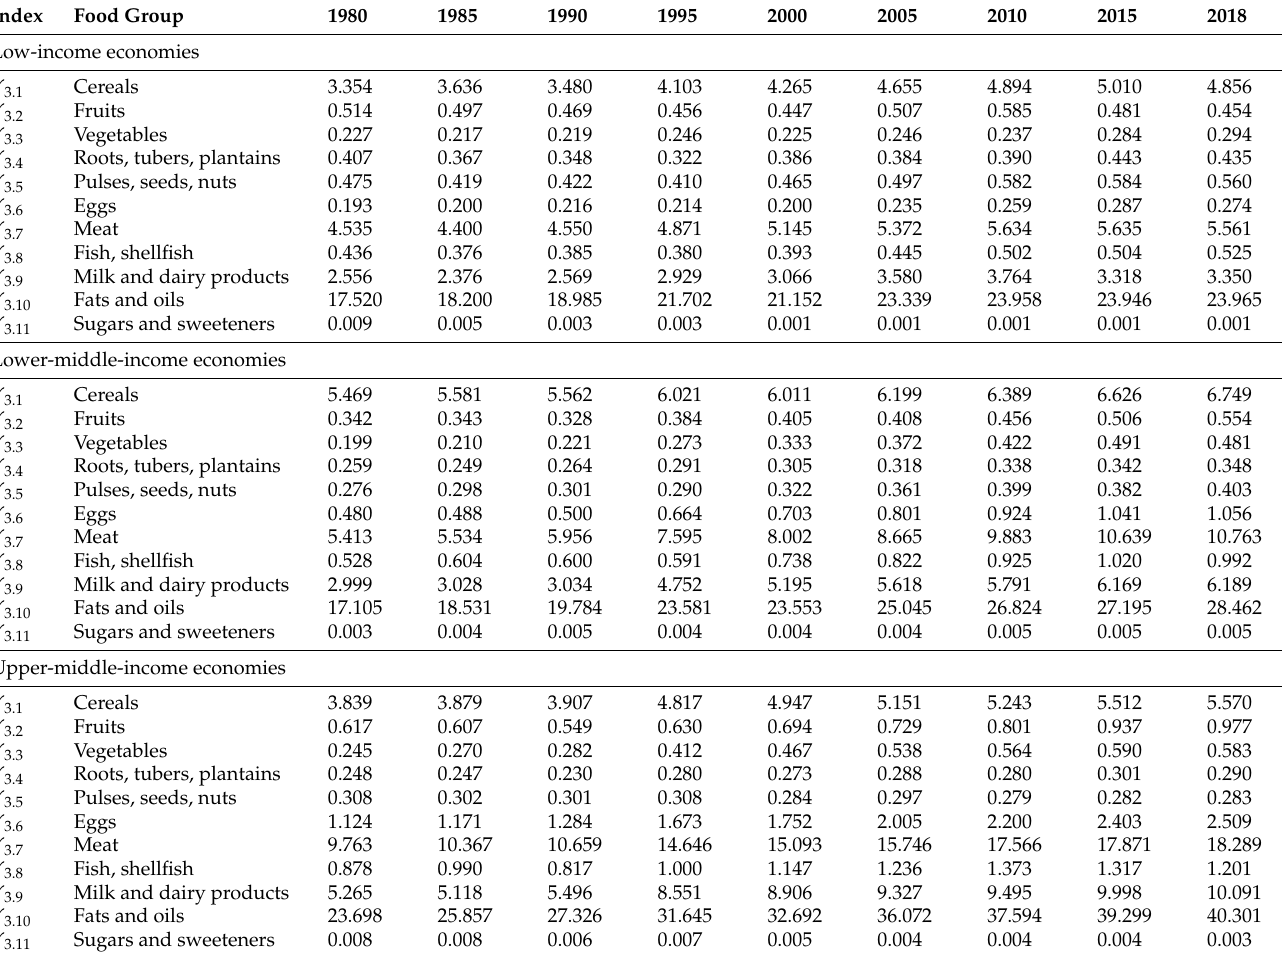
Table A3. Fat supply quantity ( Y 3 ) per country categories and food groups in 1980–2018,